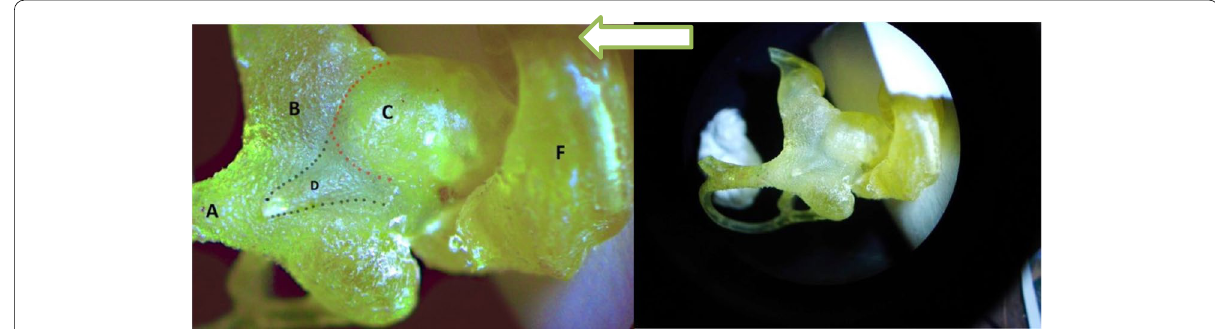
Fig. 9 A corrosion cast from plastic material of the camel inner ear. A. Common crus, B. Elliptical recess, C. Spherical recess, D. Vestibular aqueduct, F. Basal turn of the cochlea